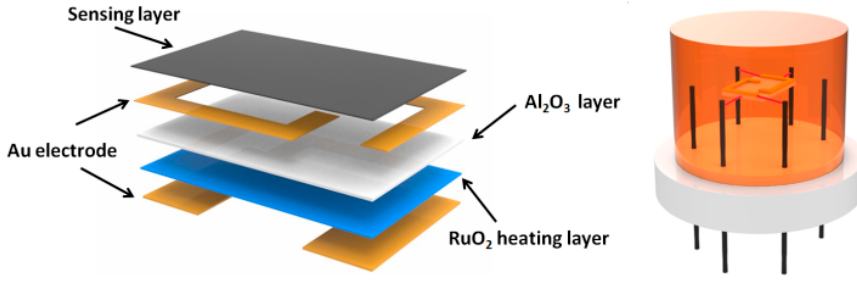
Figure 1. A schematic illustration of the sensor coated with the sensing material.